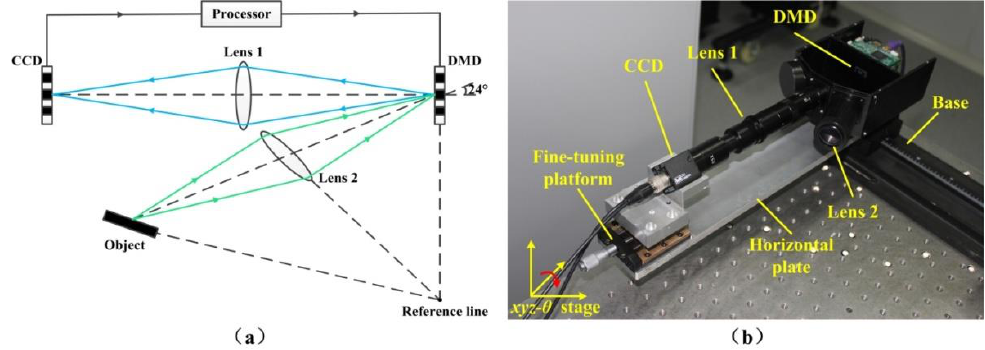
Figure 2. DMD camera. ( a ) Optical schematic of our system; ( b ) Imaging system layout.